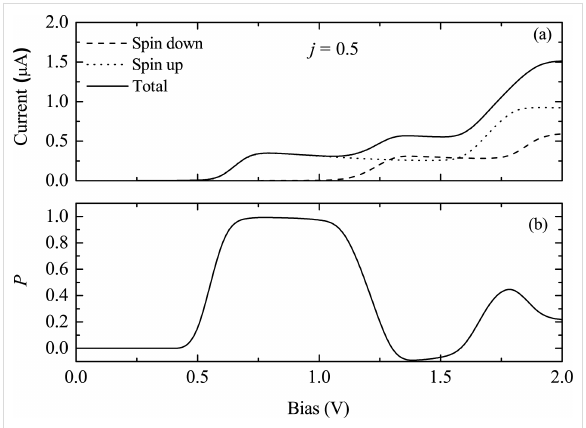
Figure 2: (a) Current–voltage characteristics for a OF device with N = 20 carbon sites. (b) Spin polarization of the current as a function of bias. Reproduced with permission from [31], copyright 2007 American Physical